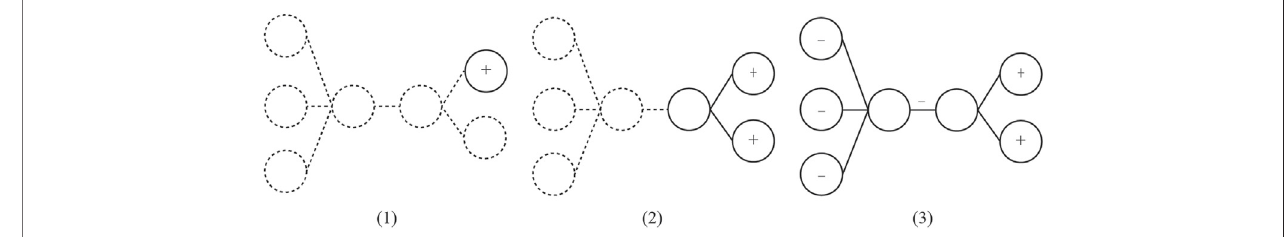
FIGURE4| Visualrepresentationofconvergencethroughoutapartialmeshnetwork.Note.Thegraph (A) showsanodeactivatedwhenthesystemdetectsanSRL behavior with the relevant information, which increases the node weight property. The graph (B) illustrates activation spread through excitatory links (i.e., positive link